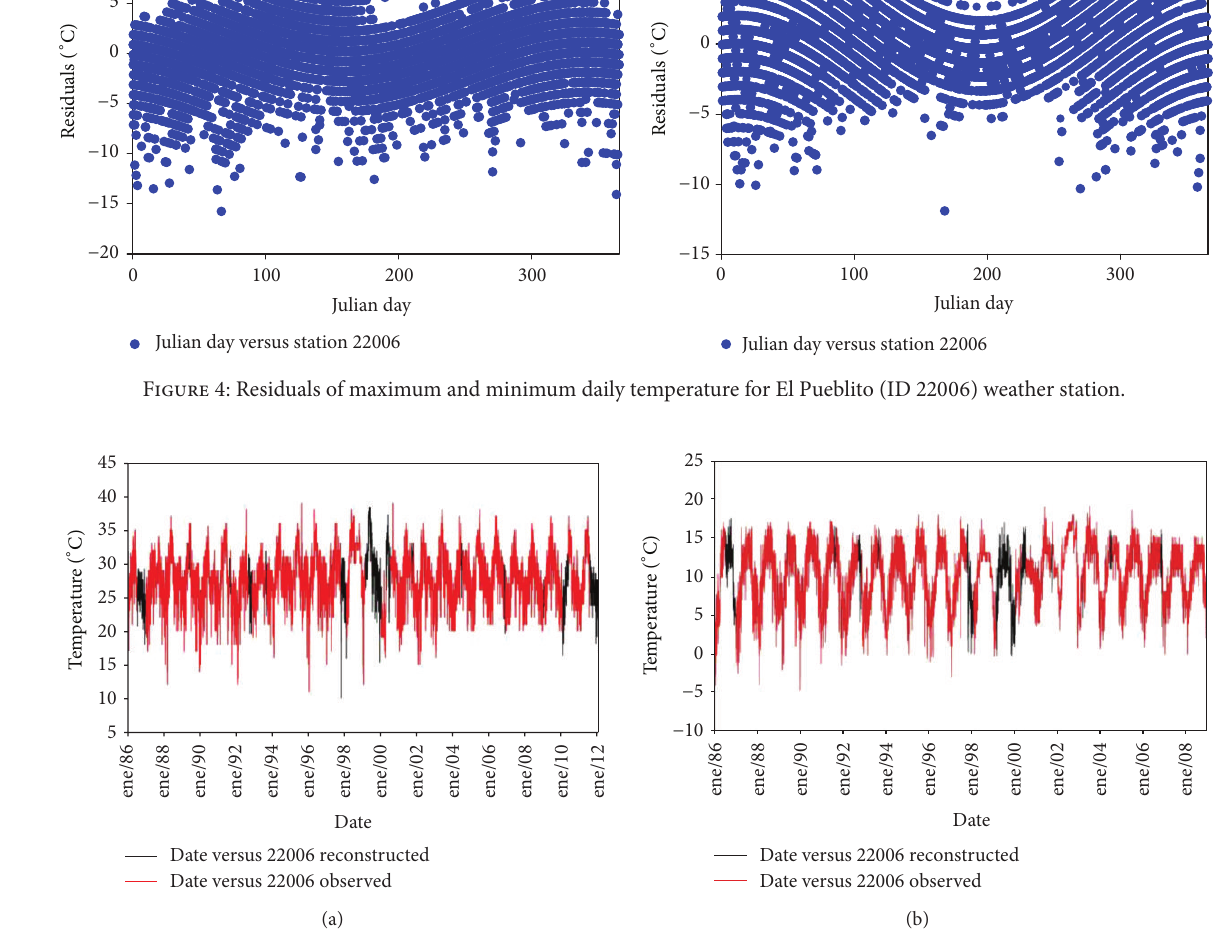
Figure 5: Reconstruction of maximum and minimum temperature data for station 22006 El